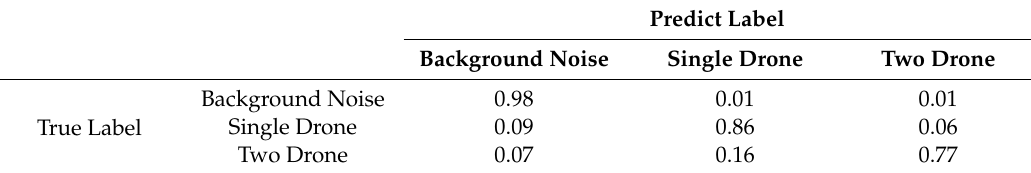
Table 7. The confusion matrix from CoNN with MIF classes.